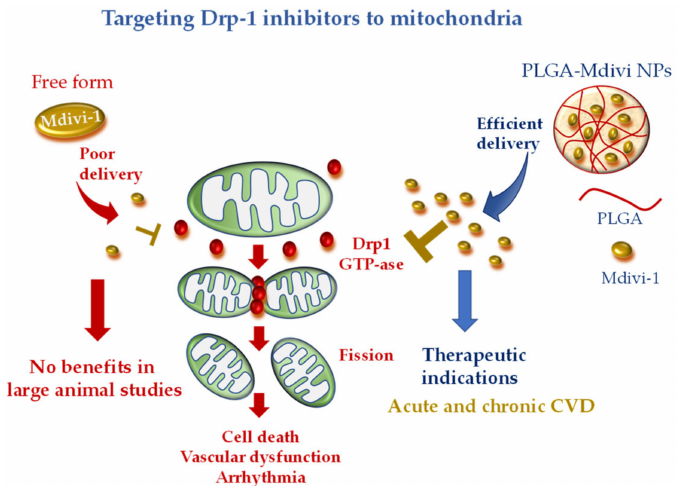
Figure 4. Mitochondria-targeted delivery of dynamin-1-like protein (Drp1) inhibitor (mitochondrial division inhibitor 1 (Mdivi-1)) in free form versus nanoparticle (NP) formulation. Free Mdivi-1